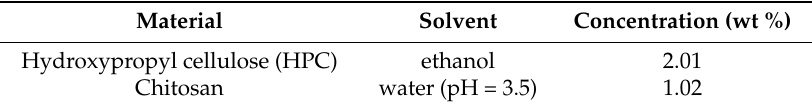
Table 1. The concentration and solvent medium for the biopolymer solutions.